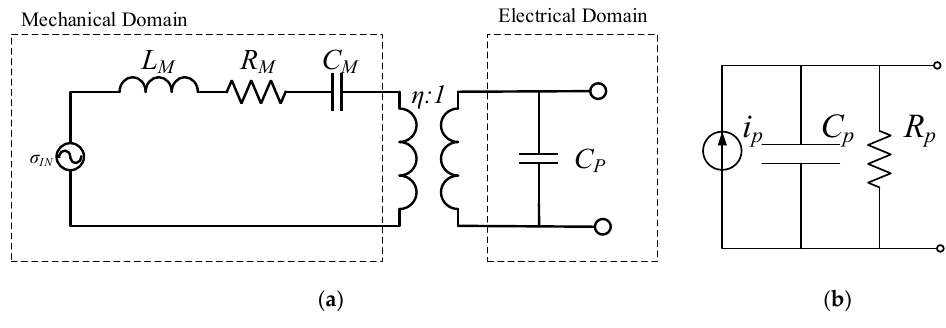
Figure 2. Piezoelectric harvester ( a ) coupled model and ( b ) uncoupled model [17].